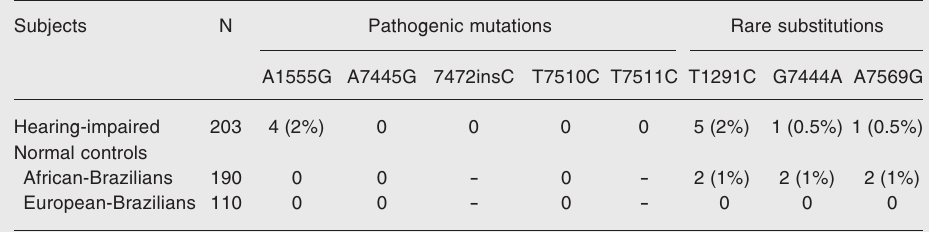
Table 1. Frequency of pathogenic mutations and rare substitutions in mtDNA detected among hearing- impaired Brazilian subjects and normal Brazilian controls. Subjects N Pathogenic mutations